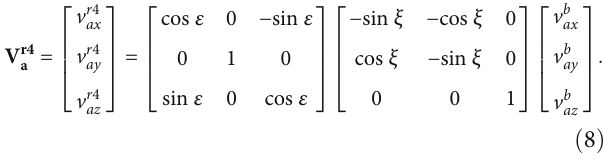
Figure 7: The NF-3 wind tunnel in NPU.